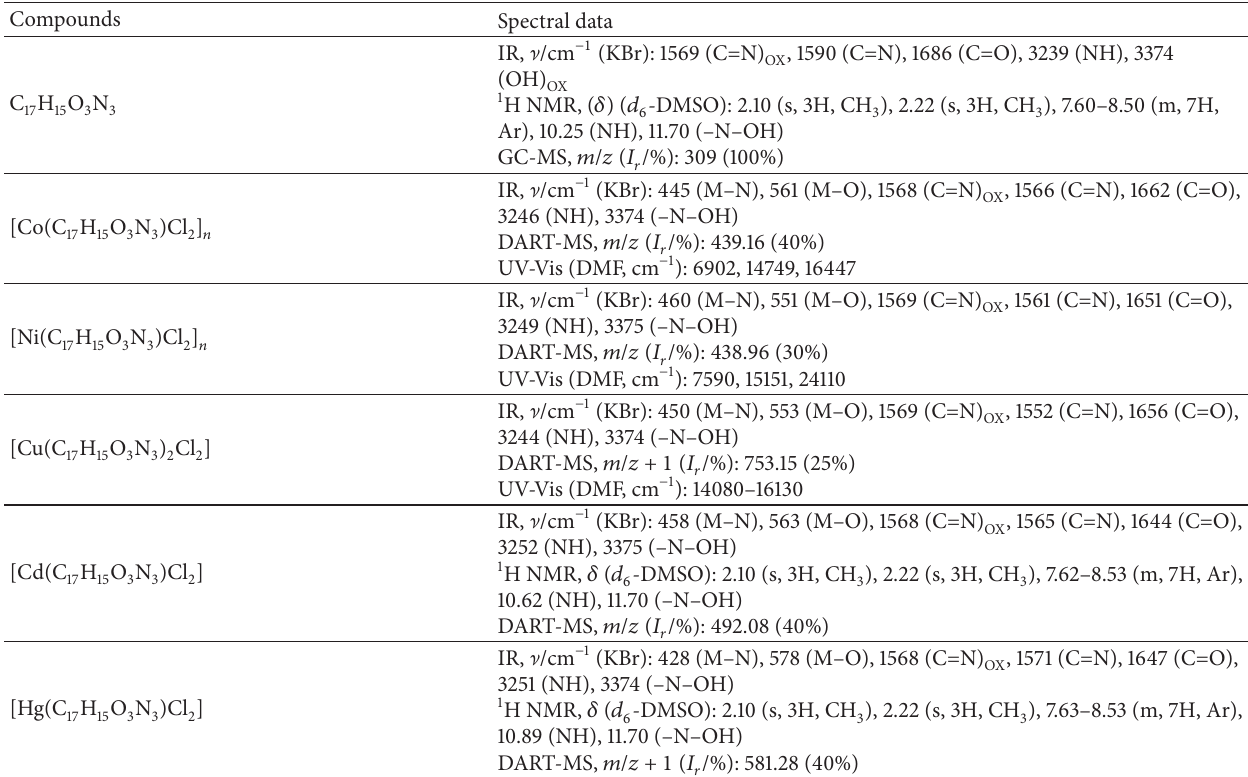
Table 2: Spectral data of all the newly synthesized